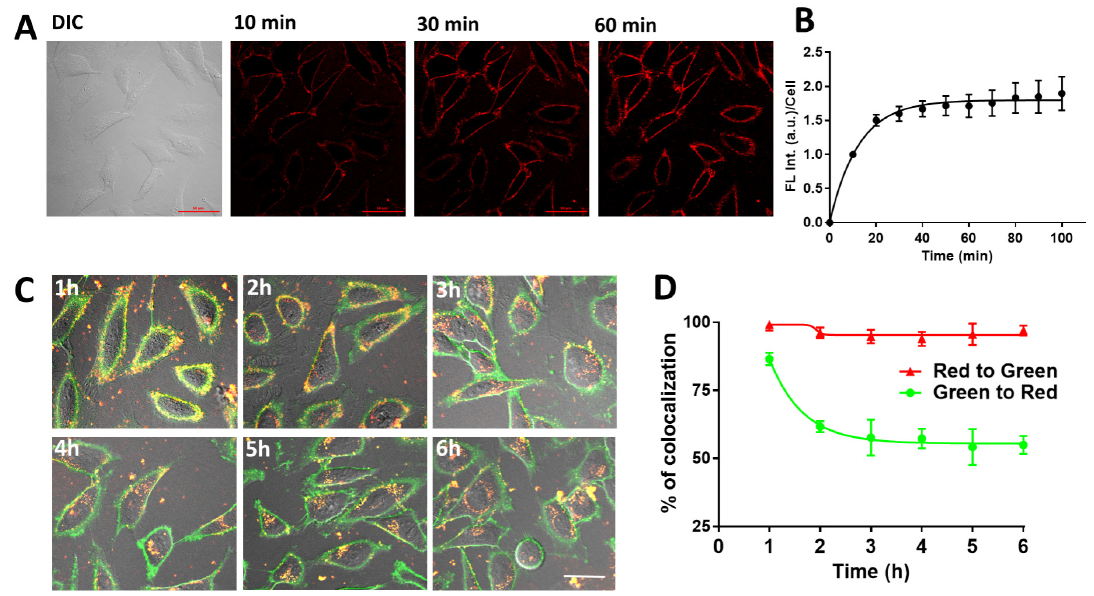
Figure 2. Cellular uptake of PY-LCNP-PEG/TEMPO . ( A ) Differential interference contrast (DIC) and confocal fluorescence images of live HeLa cells at 10, 30, and 60 min of incubation with PY-LCNP-PEG/TEMPO conjugates. The red (excitation, 488 nm; emission, 570–620 nm) emission shows PY-LCNP-PEG/TEMPO association with the plasma membrane over time (scale bar, 50 µm). ( B ) Time-resolved quantification of membrane binding of PY-LCNP-PEG/TEMPO during 60 min of incubation. The data represent the emission intensity (avg ± SEM) of 60–80 cells from two independent experiments, normalized to the emission intensity at the beginning of imaging. ( C ) Time-resolved DIC and confocal fluorescence images (merged) of live HeLa cells incubated with PY-LCNP-PEG/TEMPO and labeled with the plasma membrane probe WGA-AF488 (scale bar, 50 µm). ( D ) Time-resolved quantification of the percent of membrane-bound WGA-AF488 (green) and PY-LCNP-PEG/TEMPO (red) signals as a function of incubation time. The data were obtained from Pearson’s colocalization coefficient (PCC, n = 3 ± SD) of the green (WGA-AF 488) and green + red (PY) channels, and are expressed as a percentage after normalization to the PCC corresponding to 1 h incubation.